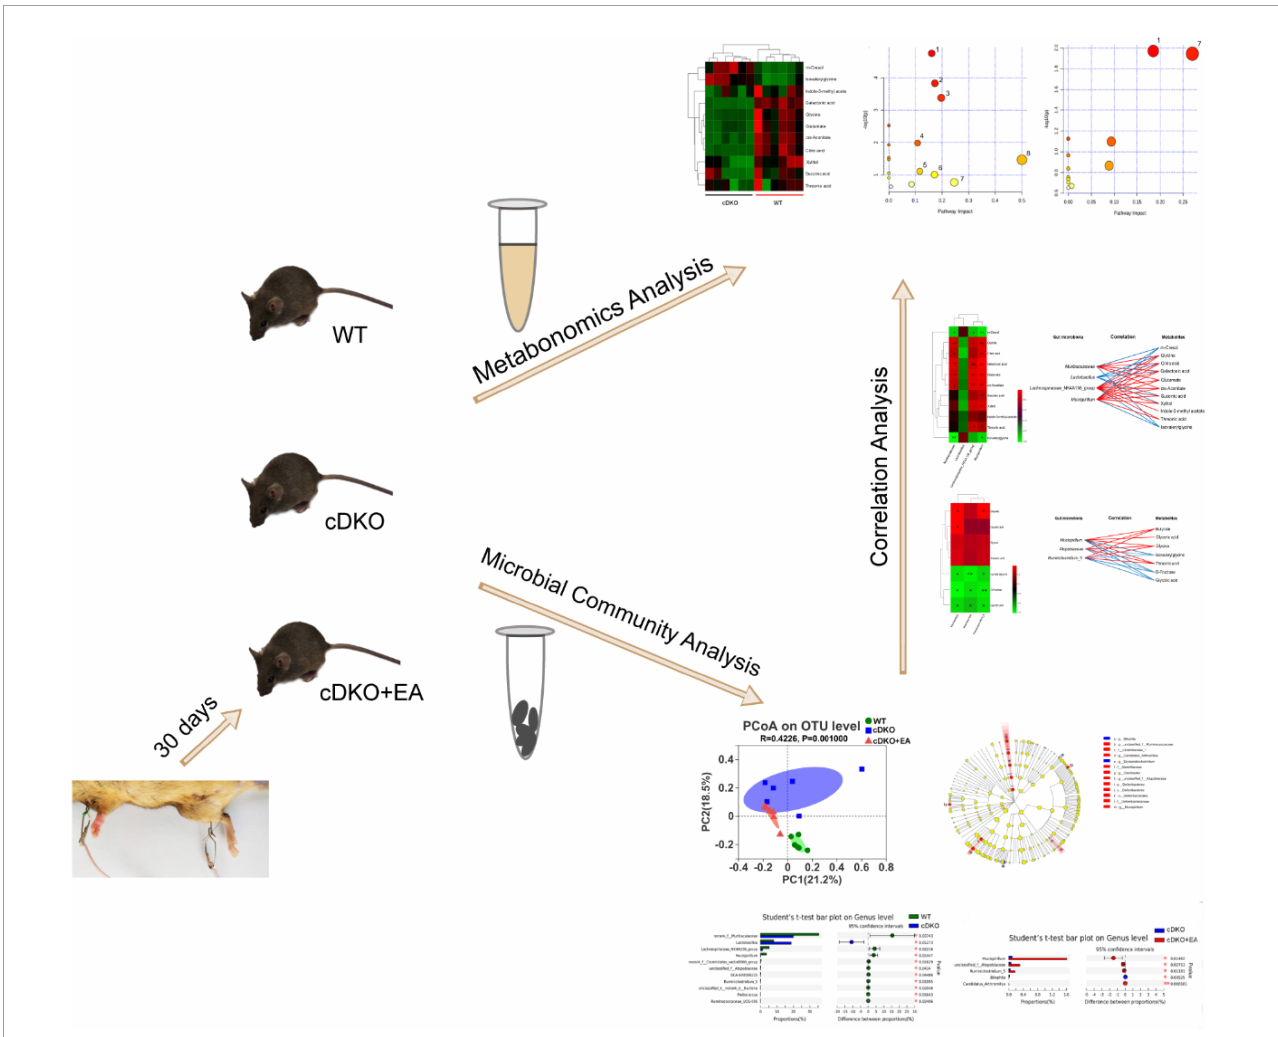
FIGURE8 Schematic diagram representing the effect of electroacupuncture on urinary metabolome and microbiota in PS cDKO mice and correlation of gut microbiota and urinary metabolome.